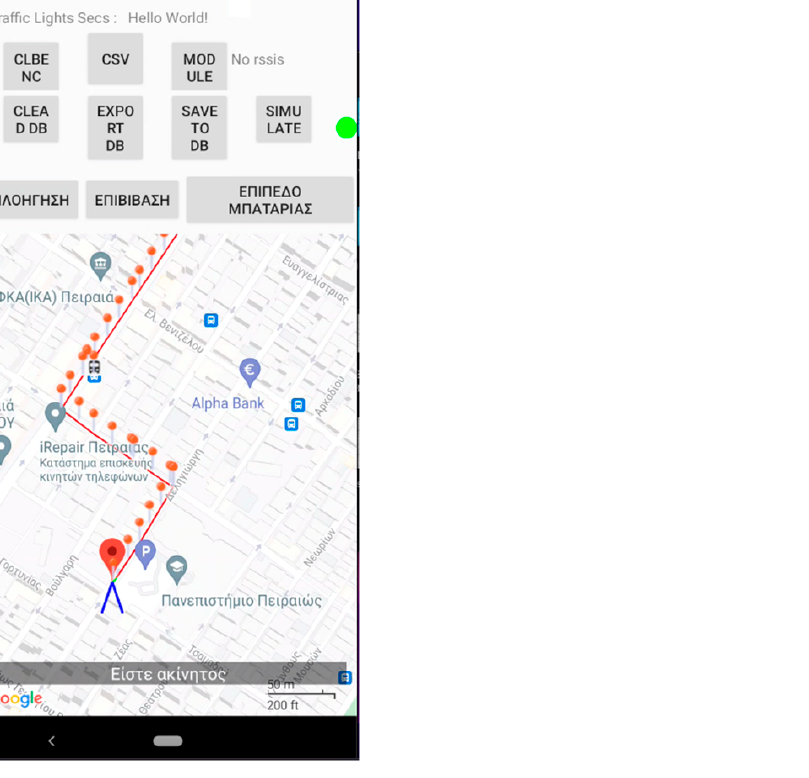
Figure 3. Application’s Training version—Route selected. The entire simulated route is depicted with dotted pins. These serve as preselected locations that the instructor can set as starting points for navigation. The message at the bottom of the image says in Greek: “You are stationary” as the replay of the route has just begun.